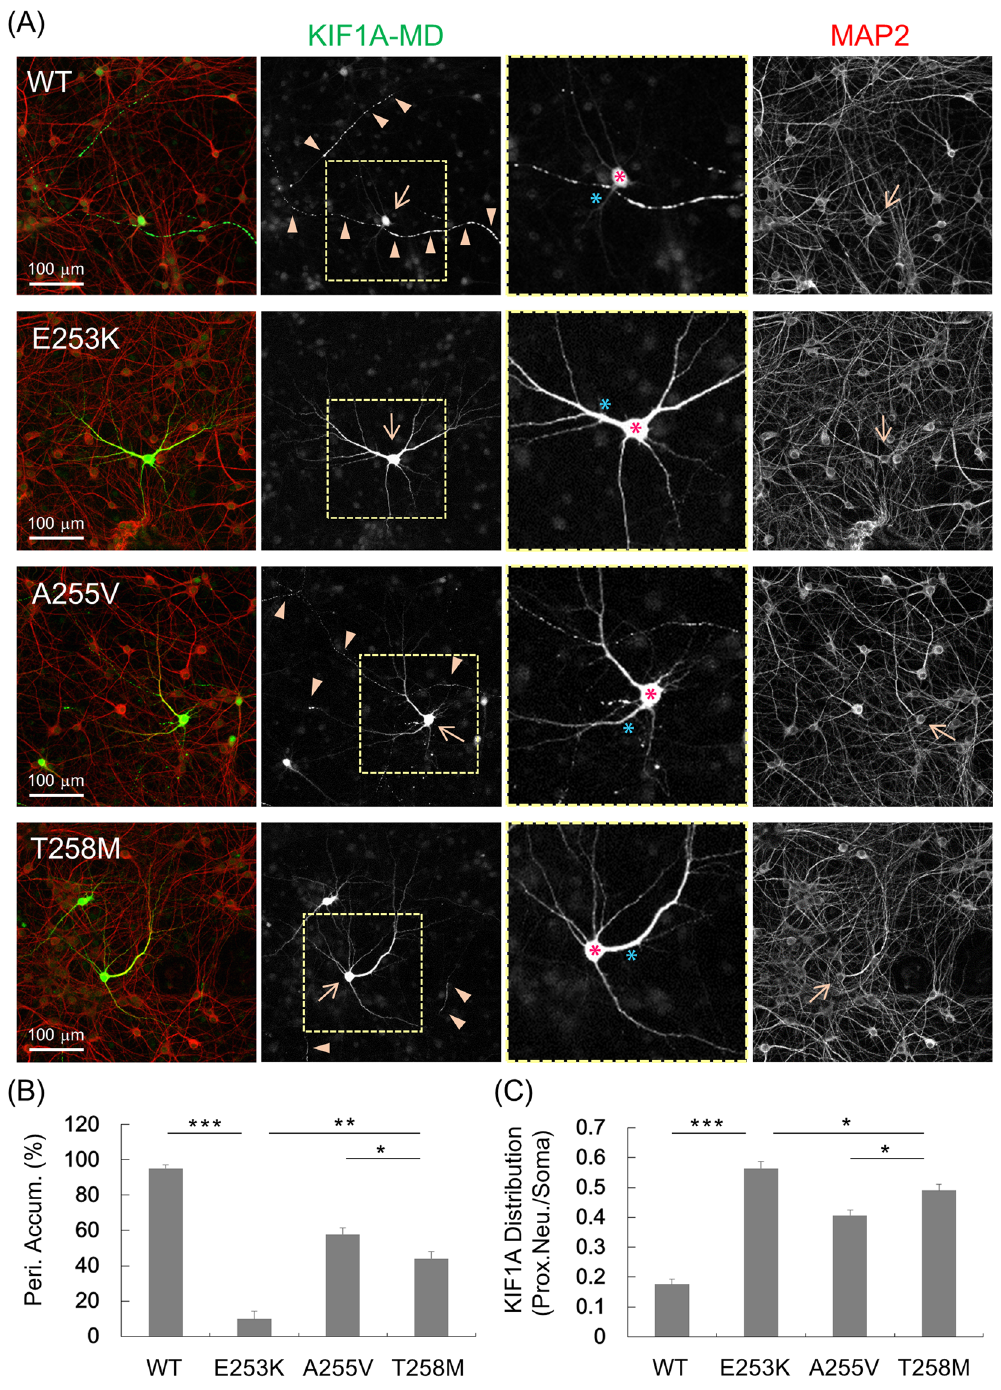
Figure 6. Functional impact of p.T258M mutation on KIF1A motor activity. ( A ) KIF1A-MD-EGFP constructs were expressed in cultured hippocampal neurons and visualized by immunofluorescence staining with anti-EGFP antibody. WT KIF1A-MD accumulated in distal regions of the axons (arrow heads), but KIF1A- MD-T258M showed a considerably reduced peripheral accumulation. The neuronal cell bodies (arrow) and dendrites were visualized by immunofluorescence staining for MAP2. ( B ) Quantification of the peripheral accumulation of KIF1A-MD (mean ± s.e.m.). The distal distribution of KIF1A-MD was analyzed as described in the methods section. Significant decreases are indicated ( *** p < 0.0001: ** p < 0.001: * p < 0.05). ( C ) Quantification of the proximal distribution of KIF1A-MD (mean ± s.e.m.). The proximal distribution of KIF1A-MD was analyzed by measuring the brightness of the proximal neurites (blue asterisk) and the soma (red asterisk) as described in the methods section. Significant decreases are indicated ( *** p < 0.0001: * p <